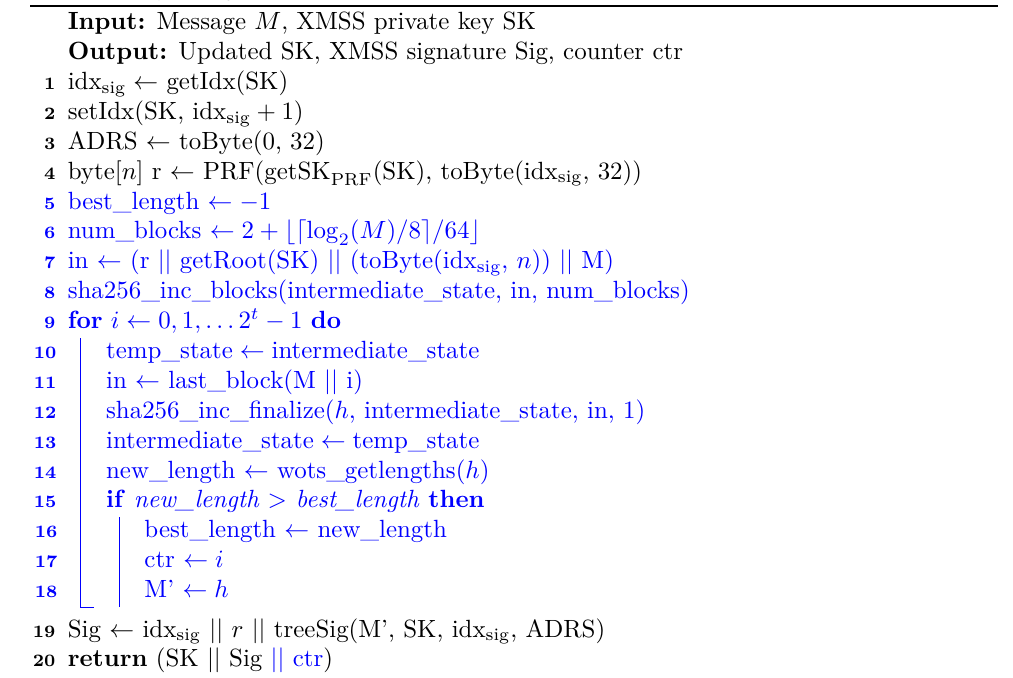
Algorithm 1: XMSS ∗ - Generate an XMSS signature and update the sign